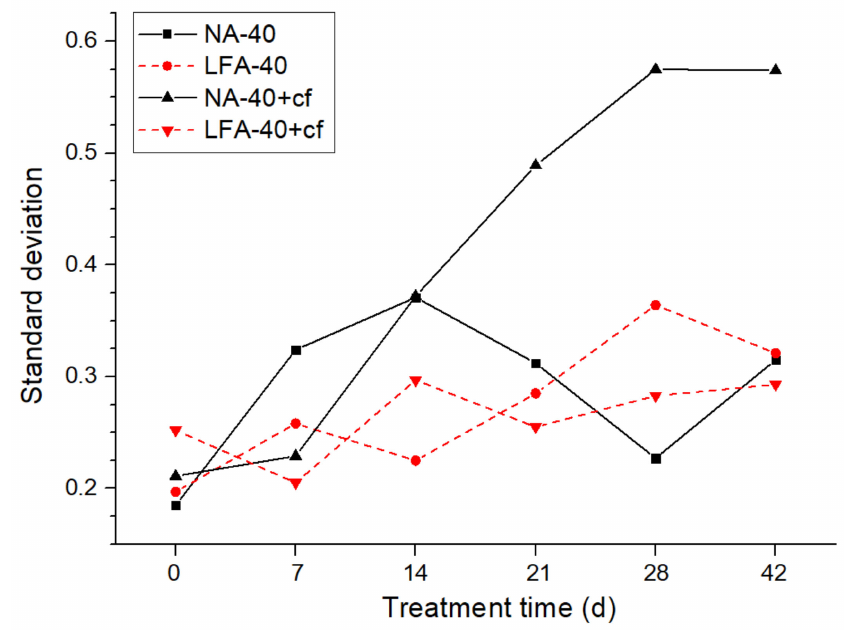
Figure 15. The relation between the normalized standard deviation of the detected current and the AAT treatment